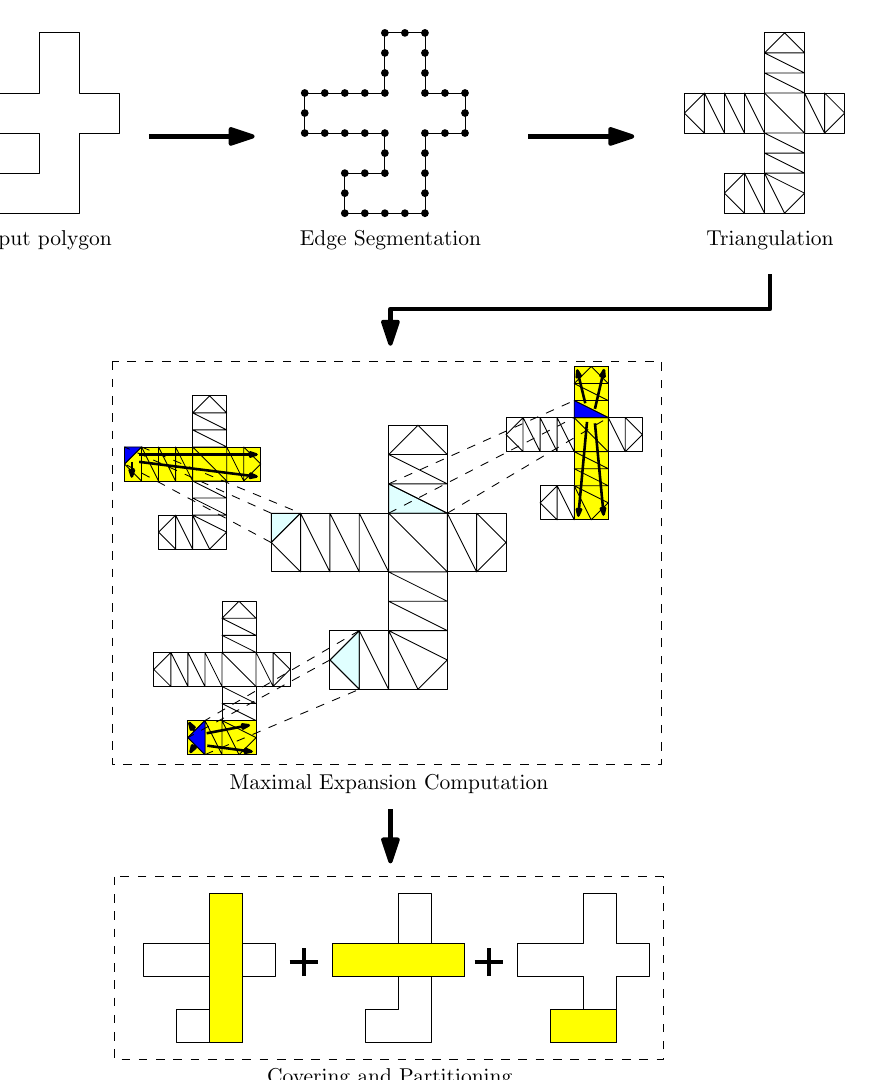
Figure 1. Overall architecture of the proposed covering and partitioning